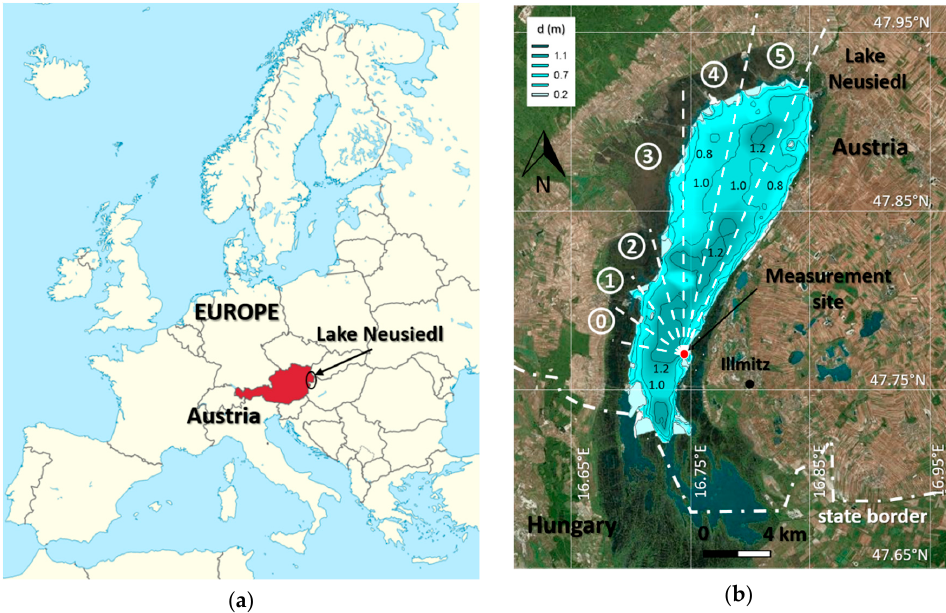
Figure 6. Lake Neusiedl depicted ( a ) in the European context, and ( b ) with the contour of bathymetry of the Austrian portion. The dashed white lines define the sectors of the blowing wind data collected by the anemometer placed in the measurement site shown by the arrow. The sectors are numbered as indicated by the circles.